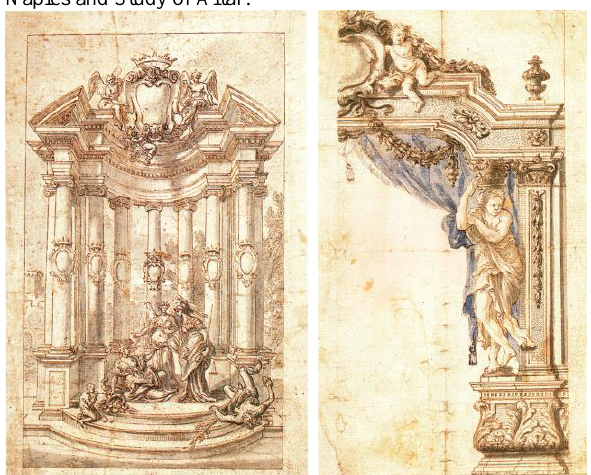
Figure 13 – Ferdinando Sanfelice, from left, celebrate’s apparatus study and portal with